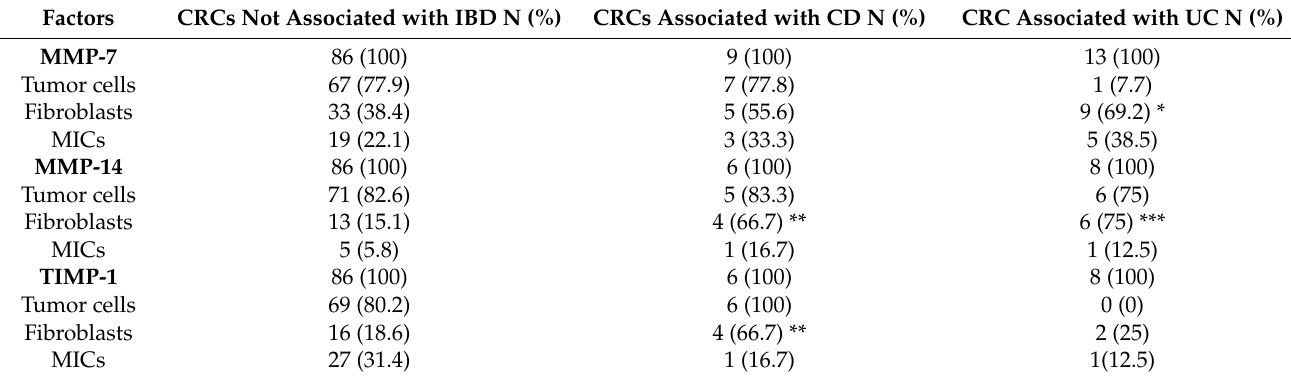
Table 3. Expression of MMP-7, MMP-14 and TIMP-1 by different cell types in CRCs not associated and associated with IBD (% of cases refers to the total number of cases analyzed indicated for each